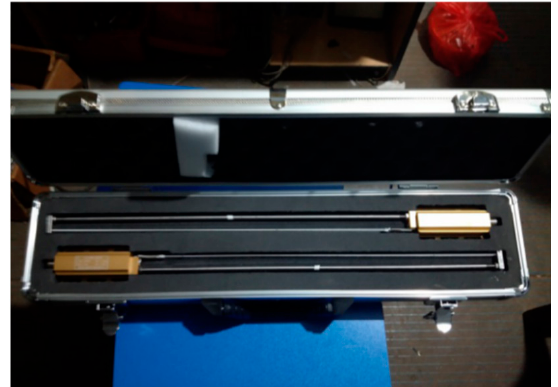
Figure 7. Wave altimeter.